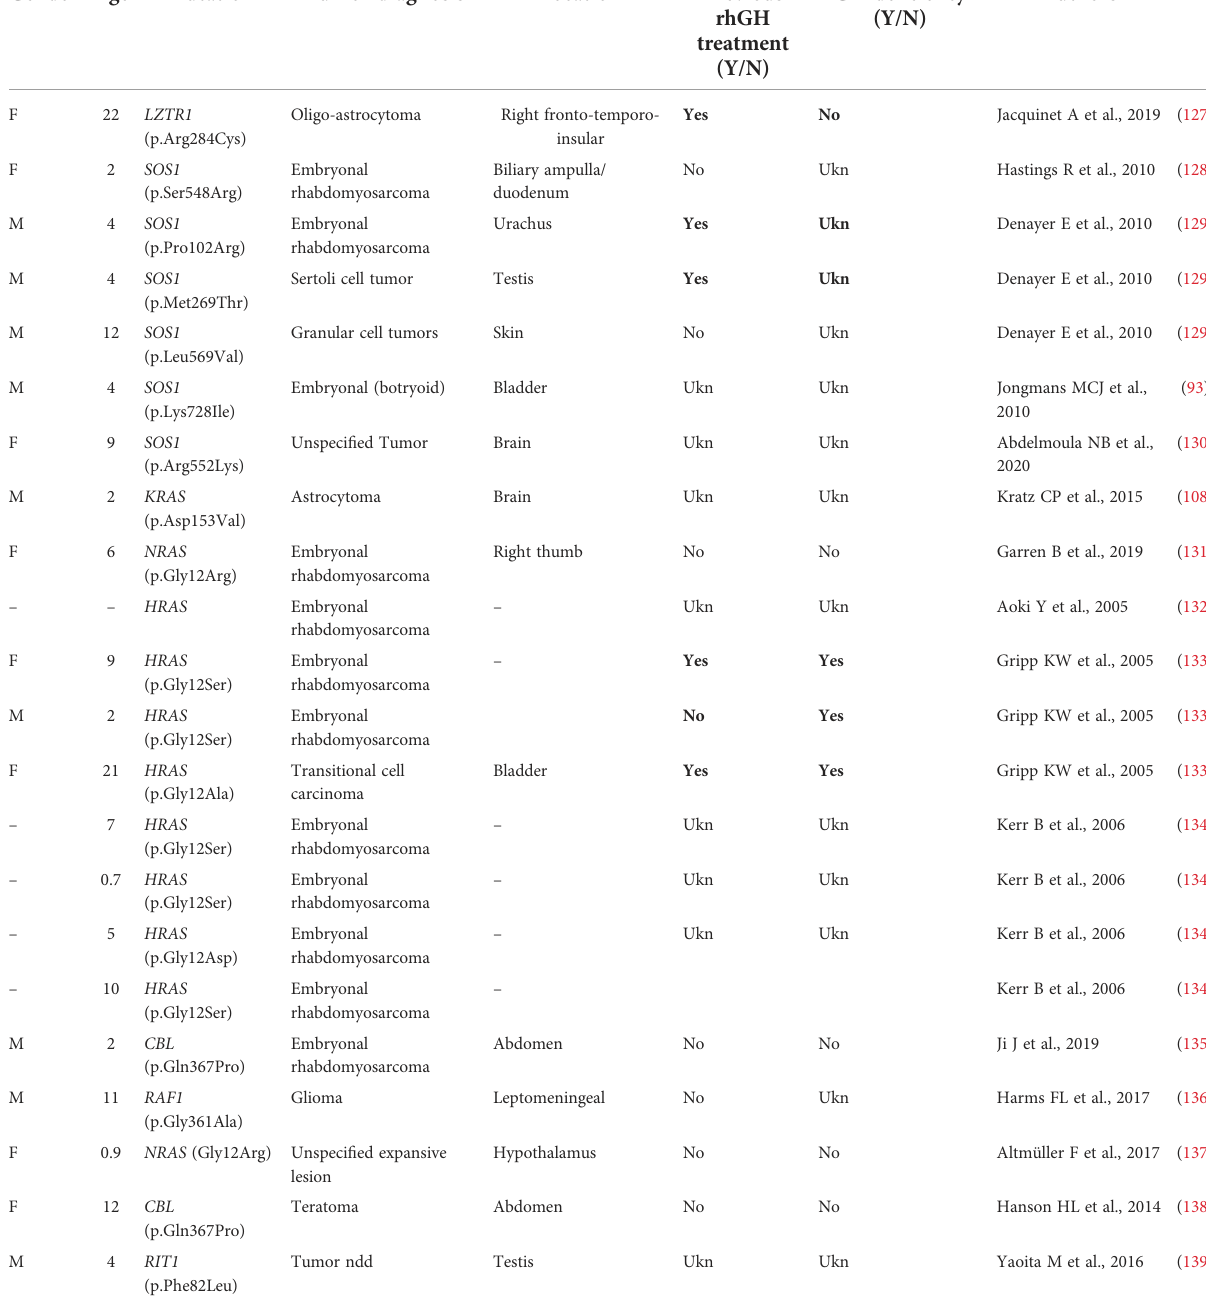
TABLE 3C Primary brain and other tumors in Noonan syndrome and other rasopathies with no PTPN11